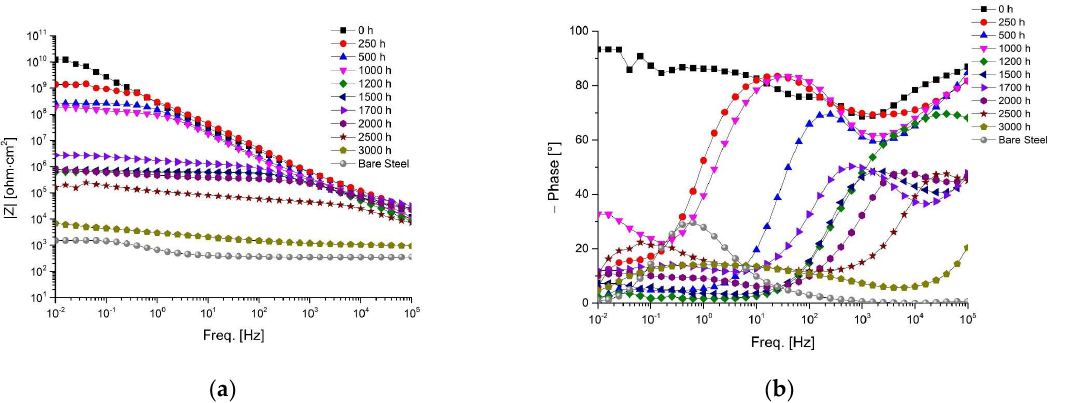
Figure 6. Example of impedance modulus ( a ) and phase angle ( b ) evolution in time for painted steel during the prohesion test.